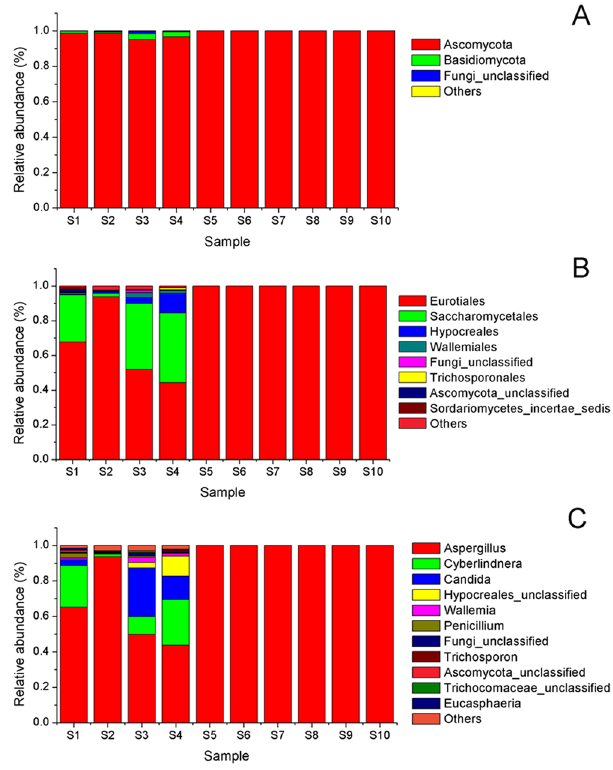
Figure 3. Fungal taxonomic compositions showing the fungal successions at phylum ( A ), order ( B ) and genus ( C ) level during manufacturing process of Fu brick tea. The taxonomic abundance < 1% were classified into “others”. Phylum level ( A ), order level ( B ), genus level ( C ).